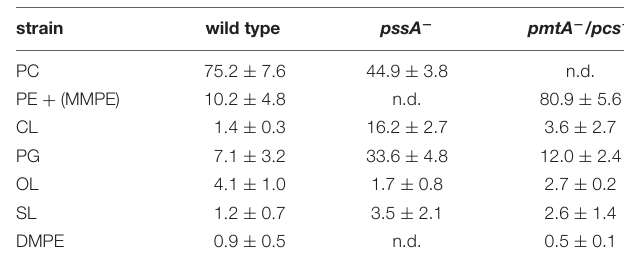
TABLE 1 | Membrane lipid composition of Sinorhizobium meliloti wild type 1021, phosphatidylethanolamine-deficient ( pssA − ) mutant CS111, phosphatidylcholine- deficient ( pmtA − /pcs − ) mutant OG10017 after in vivo labeling for 24 h during growth on complex LB/MC +